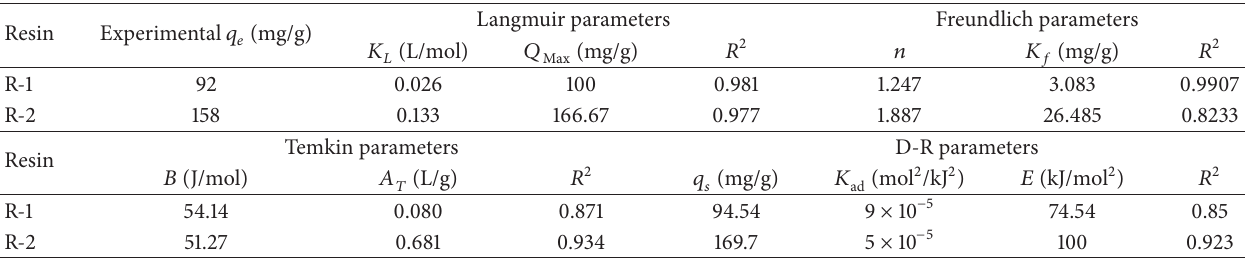
Table 3: Isotherms parameters for the sorption of U(VI) ions.